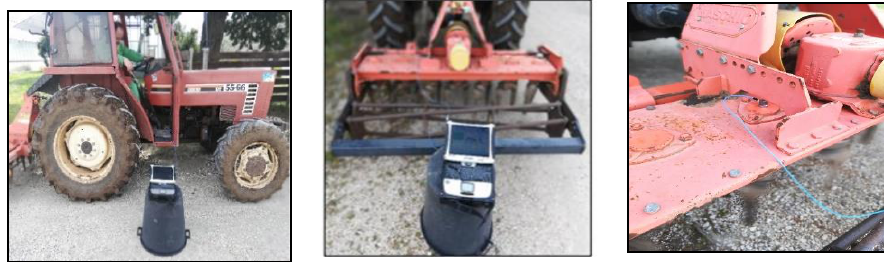
Figure 3. Positioning of the instrument near the machine and accelerometer on the harrow. Measurements were realized for each bearing from number 1 to number 6; then the last acquisition was performed on the seventh bearing while keeping the angular speed of PTO constant with the following values: 600 rpm, 1000 rpm, 1500 rpm, and 2000 rpm.